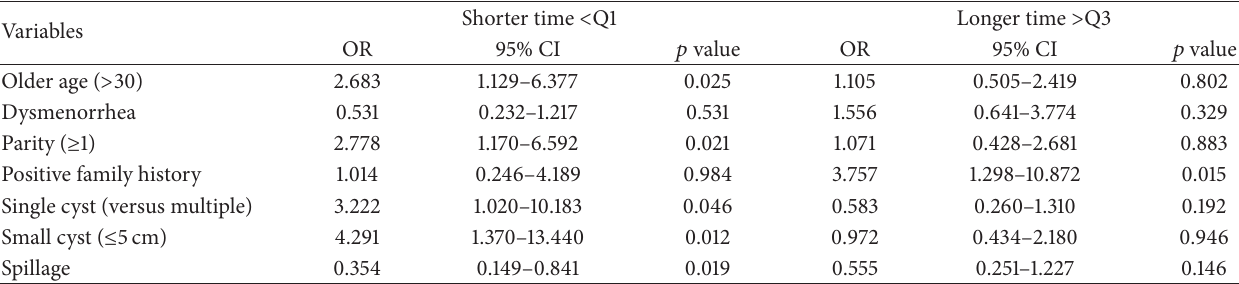
Table 3: Factors associated with shorter or longer duration of laparoscopic surgery for ovarian